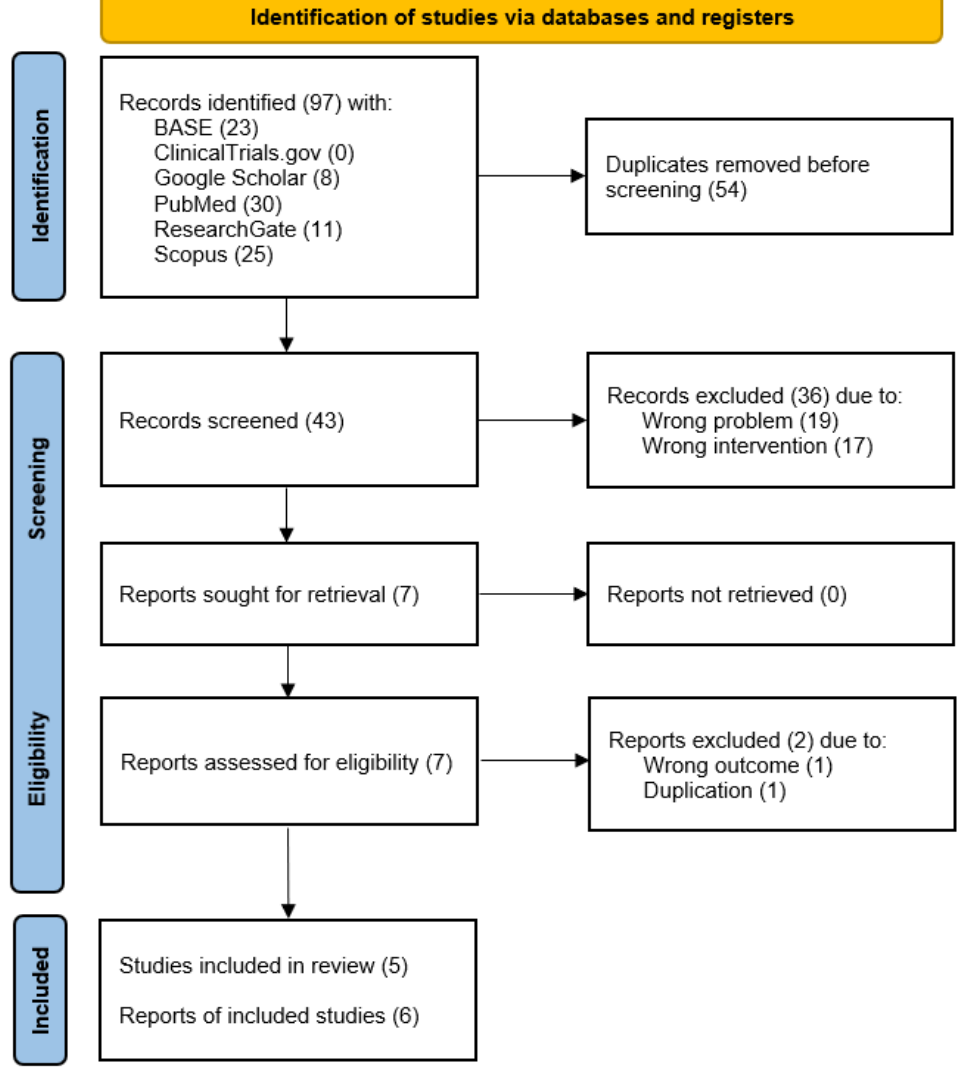
Figure 2. PRISMA flow diagram.